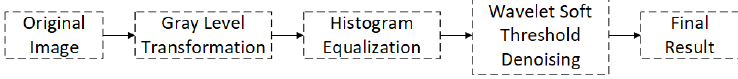
Figure 6. Flow diagram of